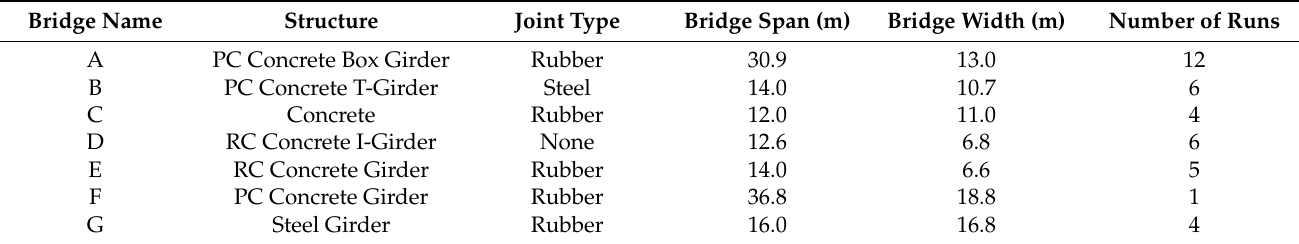
Figure 3. The GPS receiver installed on the bridge. Table 2. Specifications of the target bridge and number of runs.